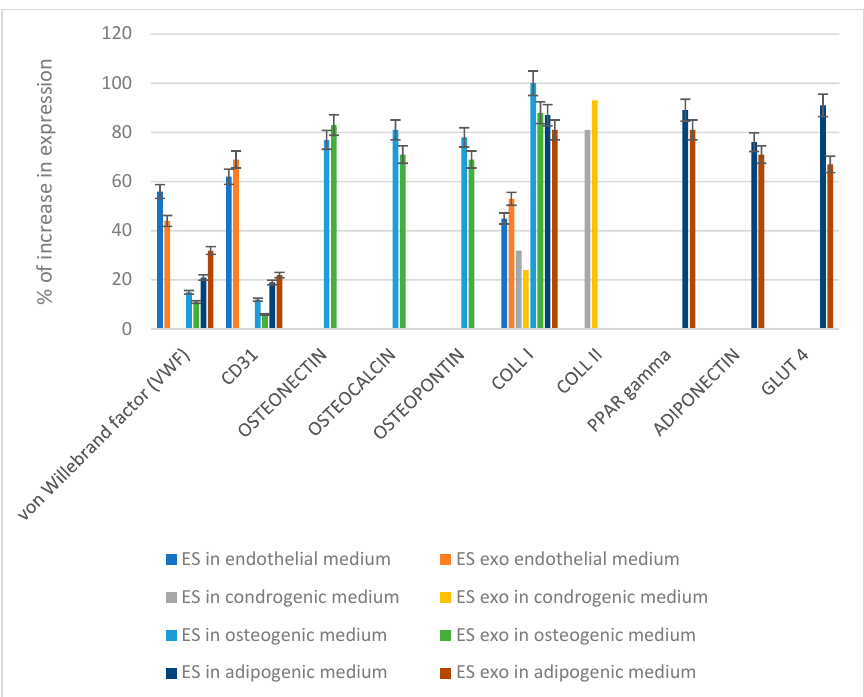
Figure 8. Gene expression according to real-time PCR on MSC previously cultured onto elastomeric scaffolds (ES) or in ES plus exosomes (ES exo) in media that induce differentiation: endothelial, chondrogenic, osteogenic, or adipogenic. Results are reported as the % of increase compared to the control (MSC in no differentiative medium).